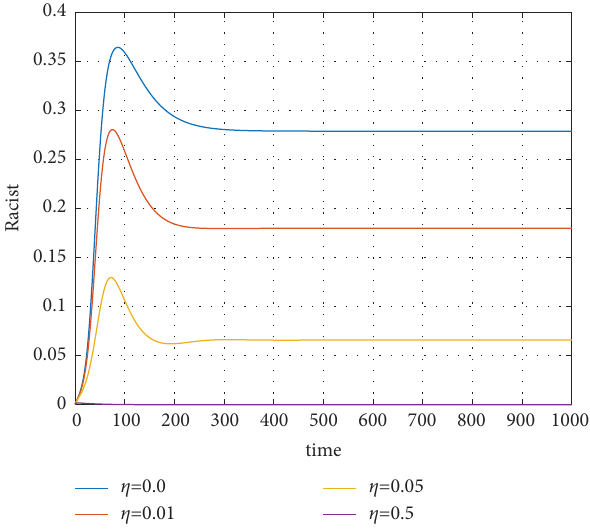
Figure 13: Te impact of η on R ( t ) .